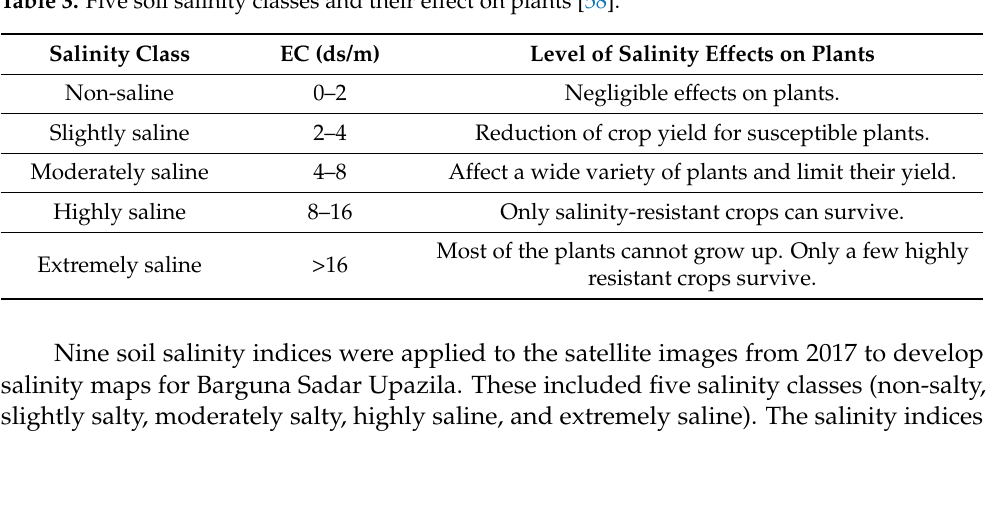
Table 3. Five soil salinity classes and their effect on plants